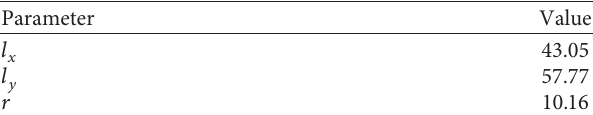
Table 2: Kinematics